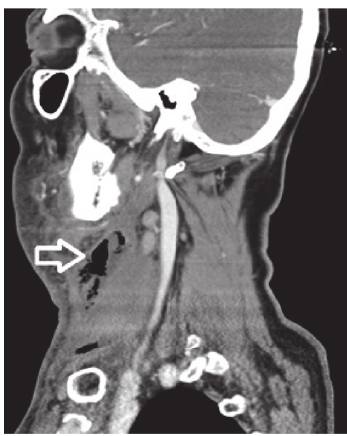
Figure3:SagittalneckCTimageshowingcervicalsubcutaneousgas (white